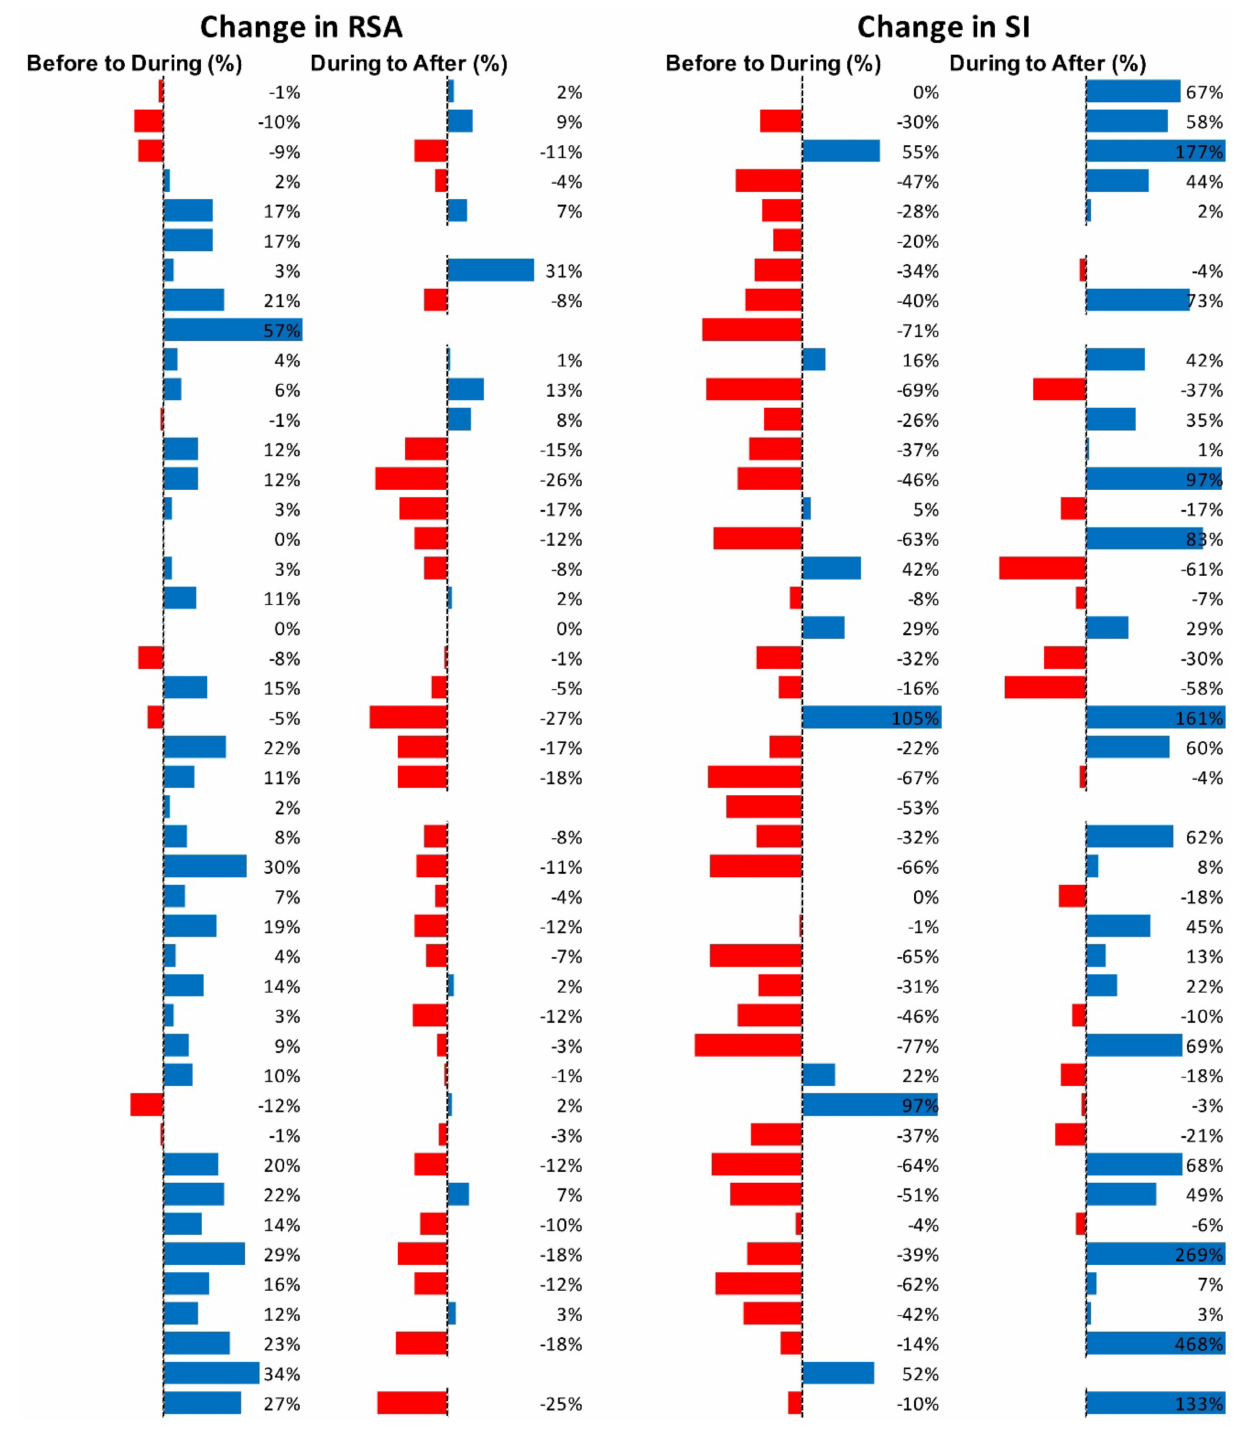
FIGURE 7 | Changes in autonomic activity in response to all HAPW-SPW’s N = 45. Data are shown as % change. The Friedman test was applied for assessment of significance followed by Dunn’s multiple comparisons test. RSA: before to during p = 0.0018; during to recovery, p ≤ 0.0001. SI: before to during p = 0.0022; during to recovery, p < 0.0001